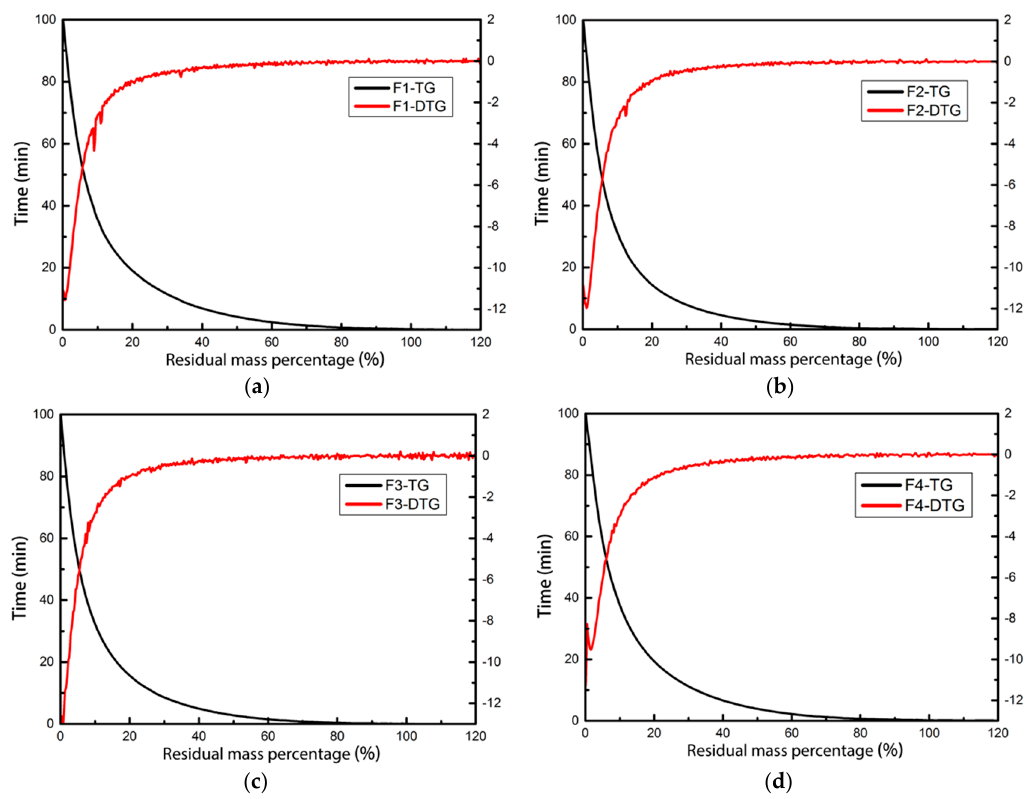
Figure 8. TG & DTG curves of nascent soot particles under different conditions: ( a ) pure ethylene; ( b ) 1-pentanol/ethylene; ( c ) 3-methyl-1-butanol/ethylene; ( d ) 2-methyl-1-butanol/ethylene.